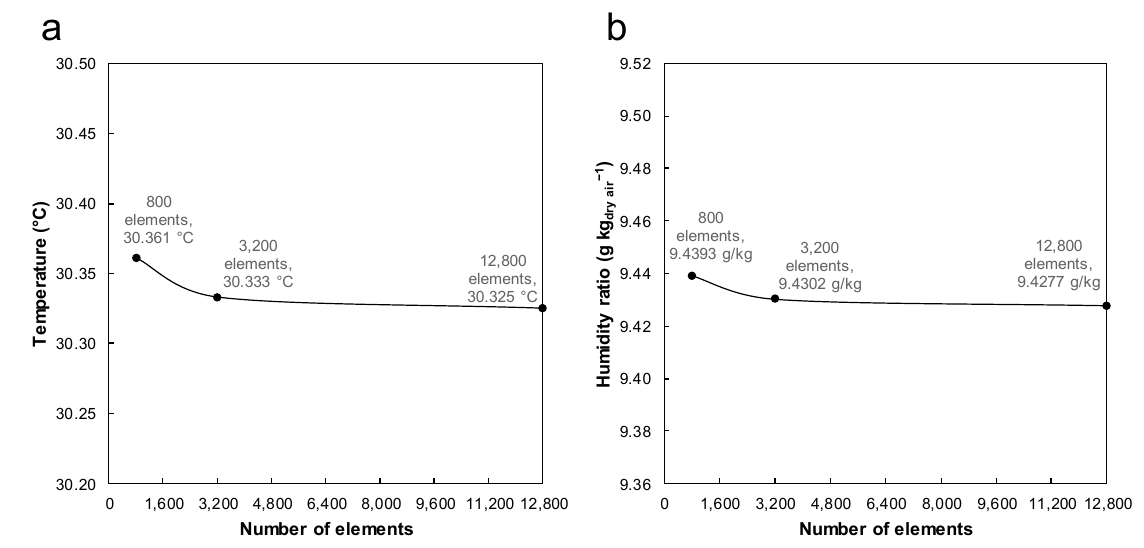
Figure 4. Predicted ( a ) supply air outlet temperature and ( b ) supply air outlet humidity ratio as functions of the number of elements.